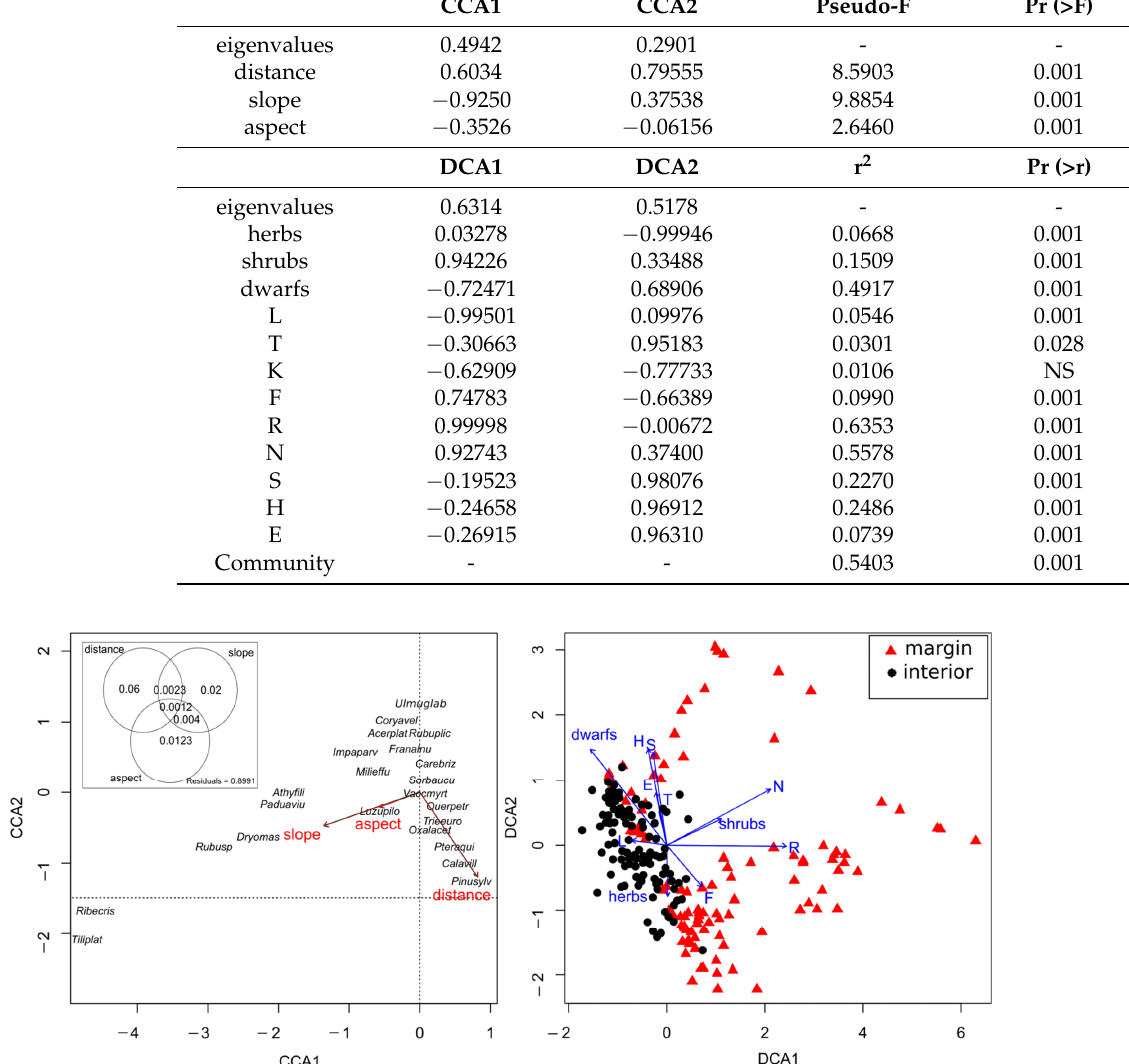
Figure 2. The biplot of the CCA ordination of the plots with statistically significant environmental variables ( left ), and the biplot of the DCA with the statistically significant ( p < 0.05) passively projected variables ( right ). The DCA analysis and the fit of explanatory variables showed that the species com- position significantly differed between the forest margin and forest interior (Figure 2, Ta- ble 4). Dwarfs and herbs as well as all of the biodiversity indices were more associated with the forest interior, while the EIV for nitrogen and soil reaction were more confined to the forest margin (Figure 2). Among the 16 response variables, only eight were found to be significant in the LMM model with a continuous distance and three variables in the LMM model with distance as a factor (forest interior vs. forest margin) (Figure 3, Table 5).